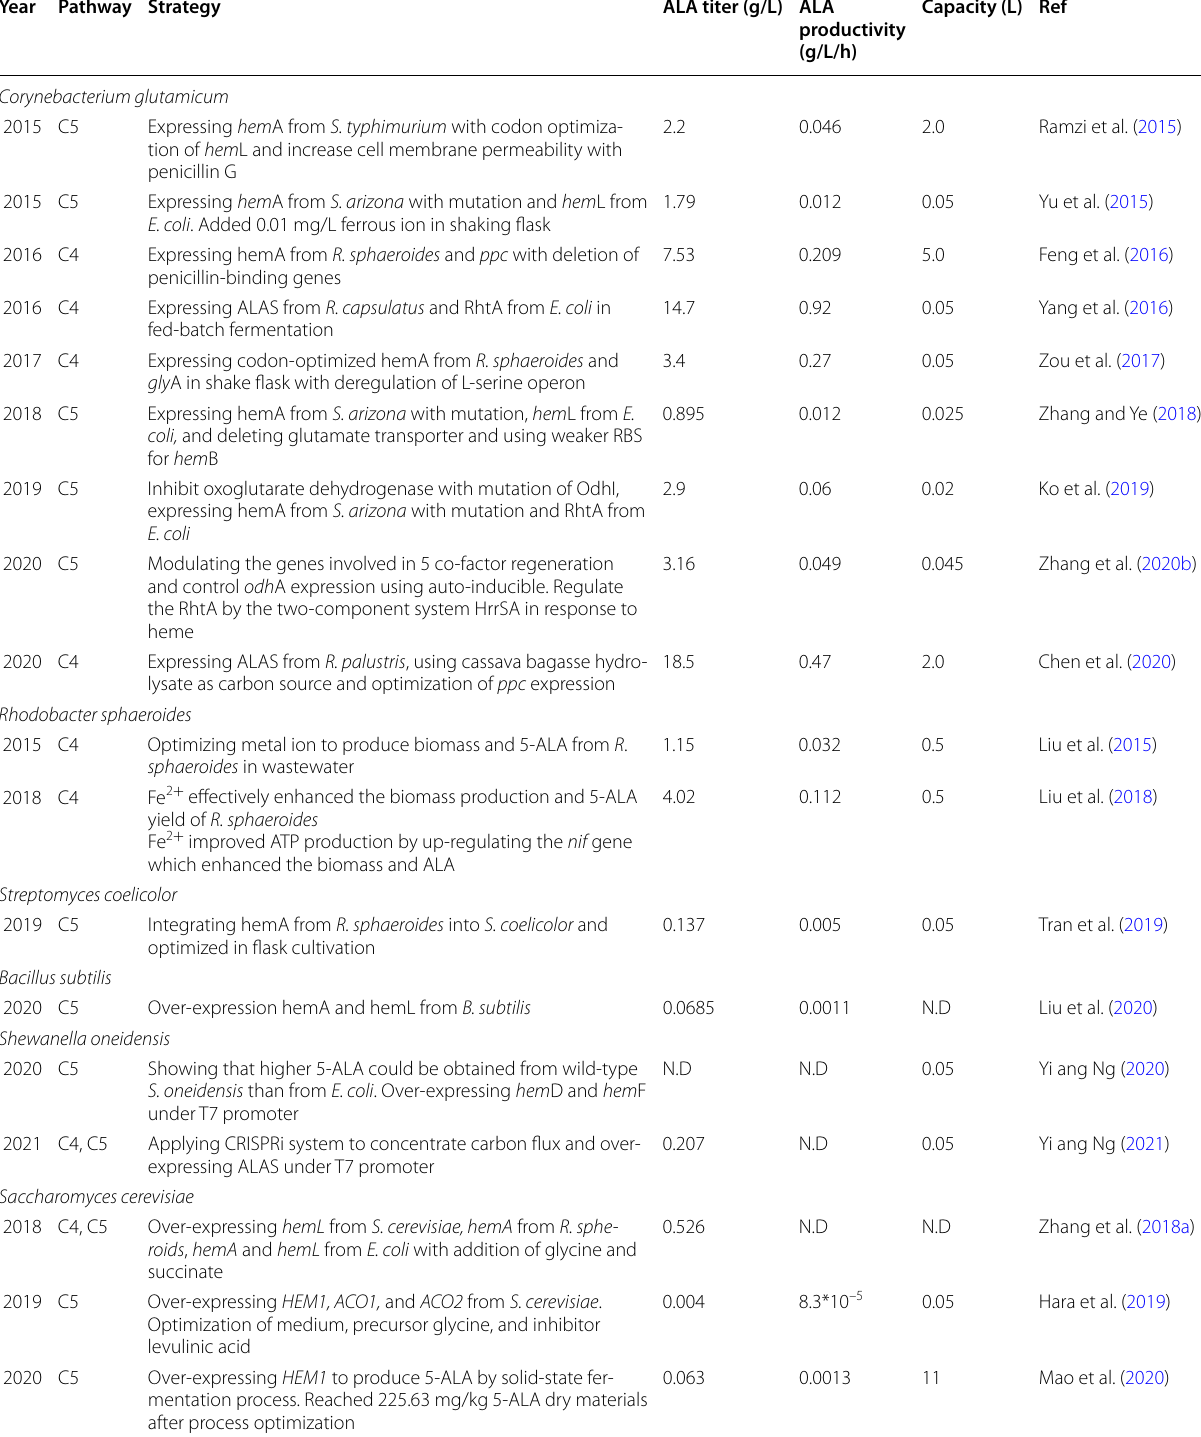
Table 4 Biosynthesis of 5‑ALA in micro‑organisms other from E.